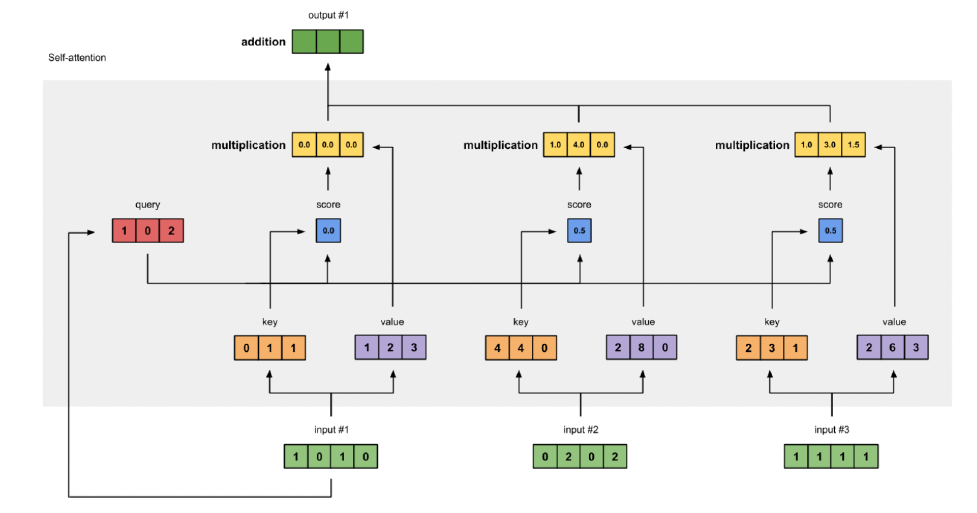
Figure 10. Self-attention mechanism. Source, accessed on 18 September 2022: https://miro.medium.